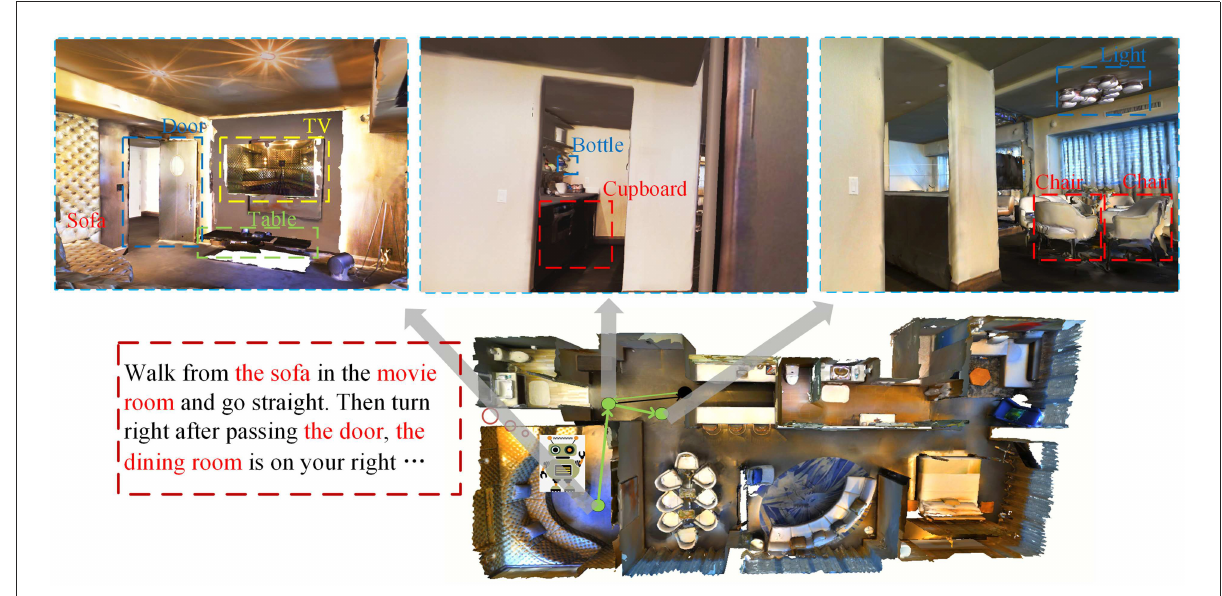
FIGURE2 Examples of the keywords of instructions and the target features of vision have certain corresponding